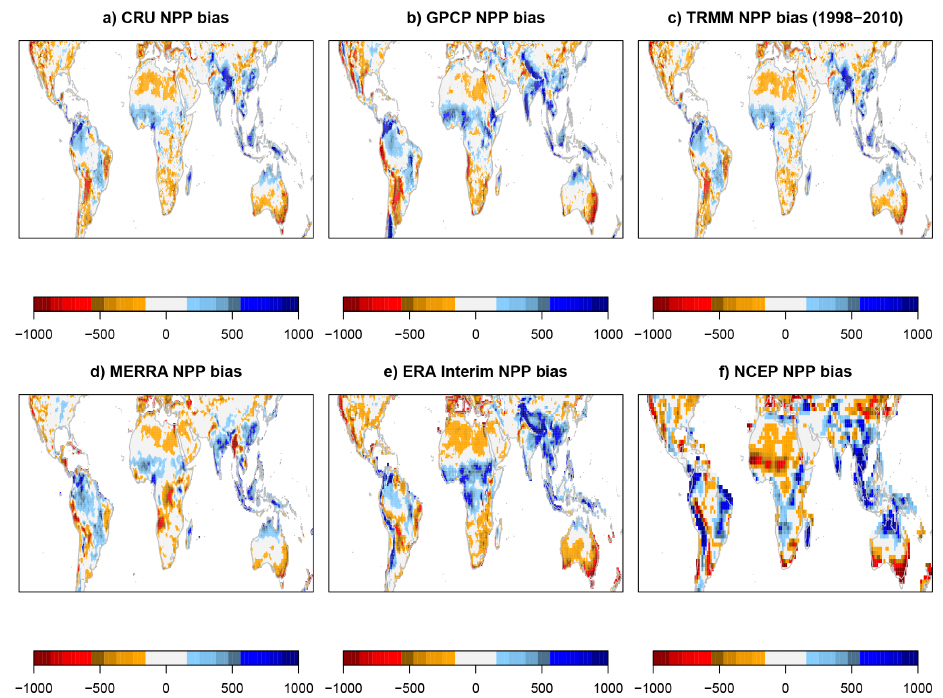
Figure 4. Mean deviation (bias) from the model NPP P − (β 1 NDVI ) for the years 1982–1999 and 2001–2010. (a) CRU data, (b) GPCP data, (c) TRMM data (1998–2010 only), (d) MERRA Land reanalysis, (e) ERA Interim reanalysis and (f) NCEP/NCAR reanalysis. The ERA Interim shows a large positive bias for tropical regions in Africa compared to the CRU and GPCP, but patterns for other continents are similar. The NCEP/NCAR reanalysis shows a consistently larger bias than the CRU and GPCP data for most vegetated